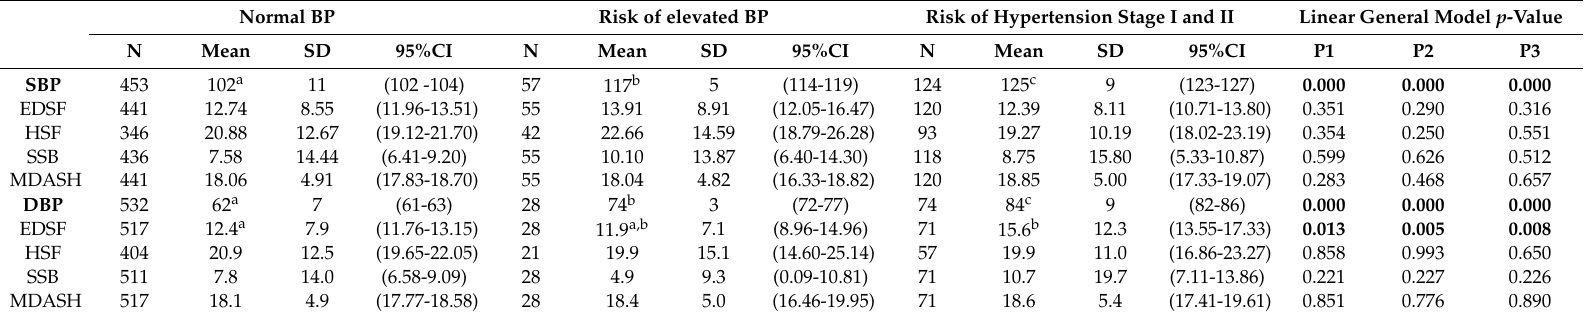
Table 2. Food group consumption according to blood pressure